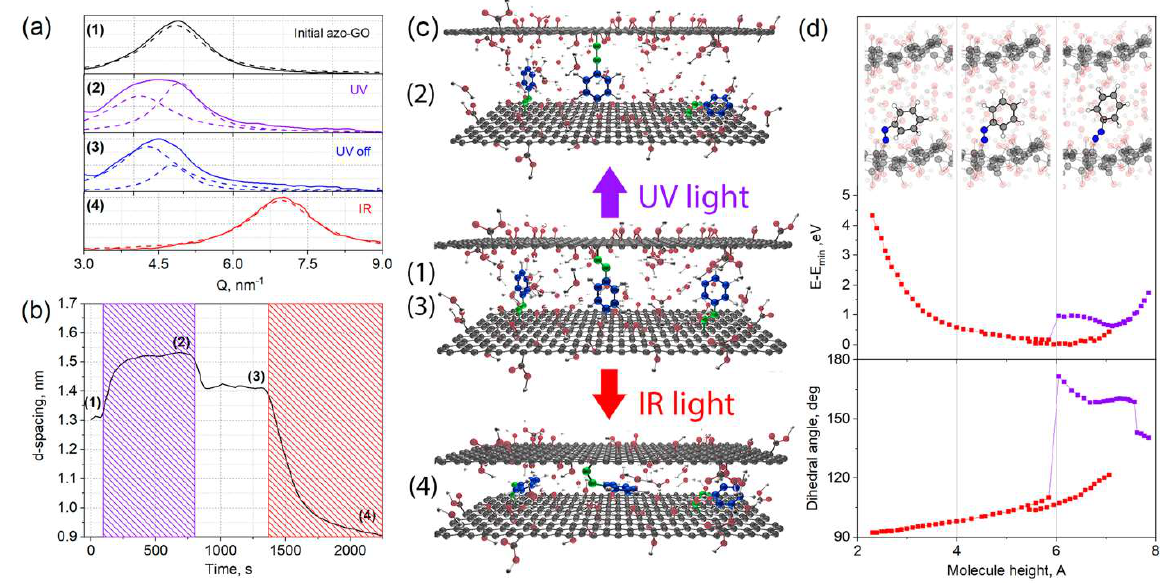
Figure 3. Experimental grazing incidence X-ray scattering data ( a ) for initial azo-GO membrane (1), the membrane exposed to UV (365 nm) illumination (2), after relaxation in the dark (3) and the membrane exposed to IR (850 nm) illumination (4). In situ variation of interlayer distance for azo-GO membrane under UV/IR exposure ( b ). Violet shaded areas indicate UV light exposure; red shaded areas correspond illumination of membrane with IR light. The measurements were performed at relative humidity of ~100%, 1 bar and 25 °C. Schematic representation of switching behavior of azo-GO membrane structure revealing the changes of interlayer spacing with cis-trans-isomerization of azobenzene fragments between graphene oxide nanoflakes ( c ). The attribution of the structures is given on ( a – c ) with numbers 1–4. The energy profiles and dihedral C–N=N–C angles for azobenzene fragment according to semi-empirical modelling of azo-GO structure ( d ). The corresponding conformations of the fragment are depicted on the top of ( d ). Excessive water-filled space coincides an ability of GO layers shrinkage with decrease of water chemical potential (humidity).